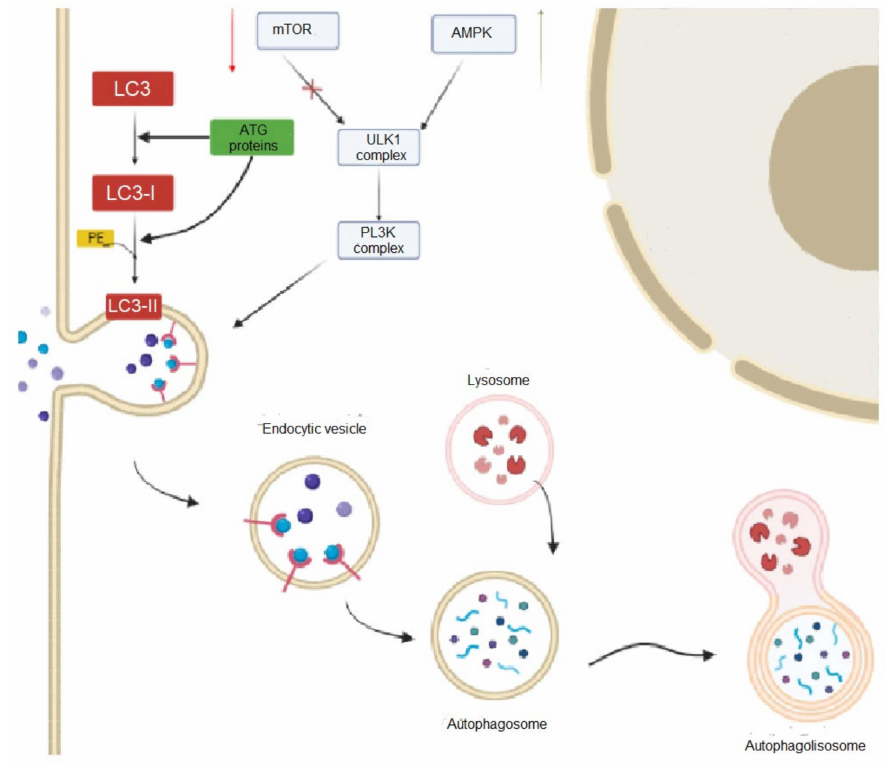
Figure 2. Overview of the main steps of macro-autophagy in mammal cells. In this pathway, the process of lysosome delivery is assisted by a double membrane-bound vesicle and the autophagosome that fuses with it to form the